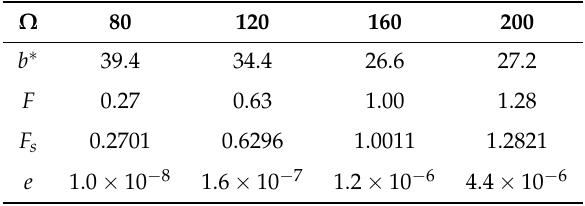
Figure 8. Simulation result plots of x s , ˙ x s , ¨ x s , F s under the given conditions Ω = 160 rev/s and µ ∗ = 0.539. Table 3. The summary of the experimental results in Section 4.3.